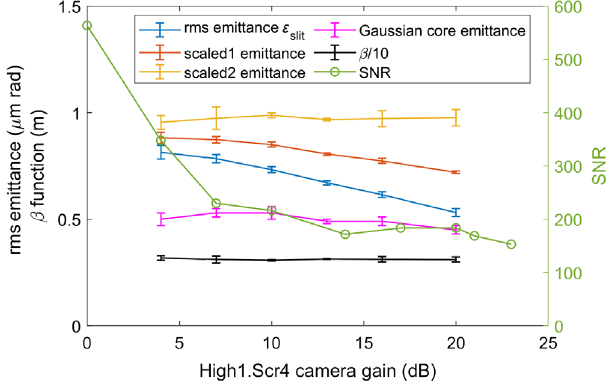
FIG. 5. Slit scan measurement of the 1-nC beam (with flattop temporal laser) vs measurement camera gain, maximum beam signal from camera CCD reading is kept the same during gain